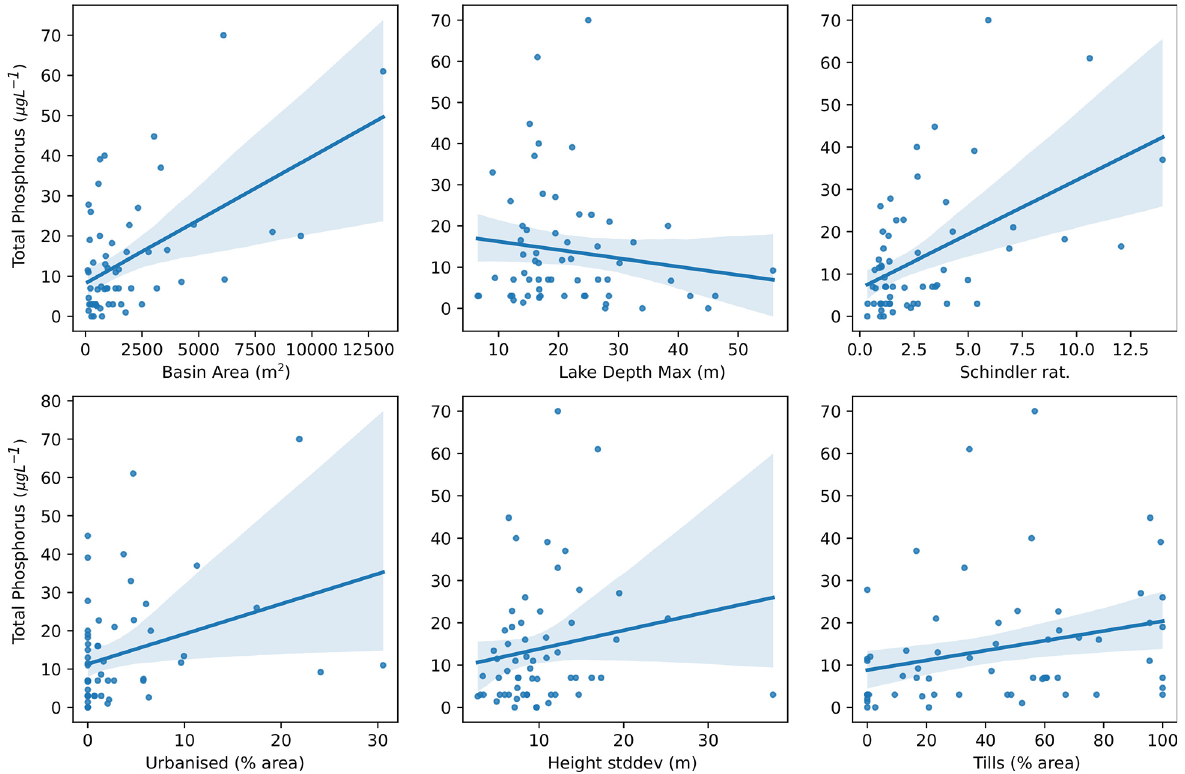
Fig. 2. Relations between P and selected explanatory variables, see Table 1 for details. tot